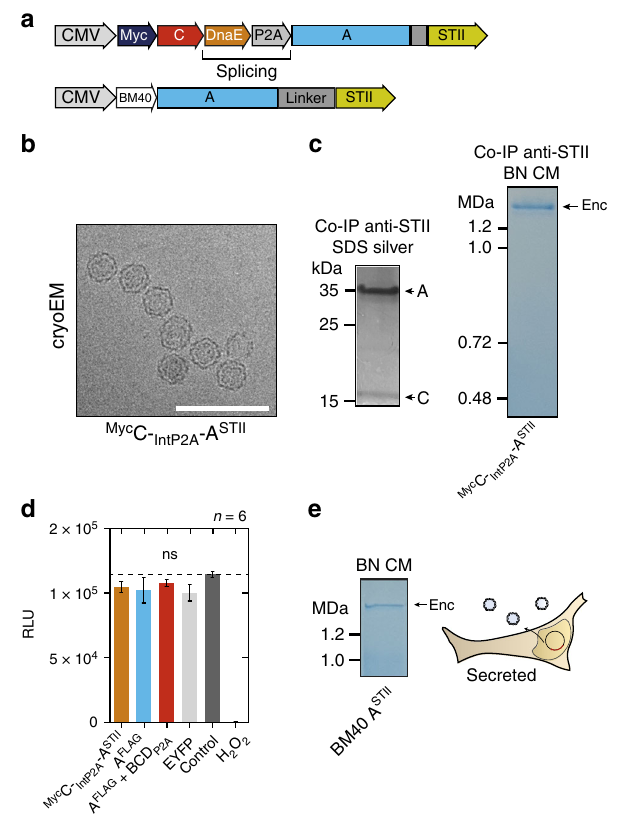
Fig. 2 Combined encapsulin:cargo construct and secreted encapsulin variant. a Scheme of a P2A bicistronic expression construct encoding StrepTagII-tagged ( STII ) nanocompartments containing Myc-tagged C as cargo protein ( Myc C- IntP2A -A STII ) as well as a variant with an N-terminal BM40 secretion peptide and StrepTagII ( STII ). b Cryo-electron microscopy image of material from HEK293T cells expressing Myc C- IntP2A -A STII puri fi ed via Strep-tag II/Strep-Tactin XT af fi nity chromatography showed